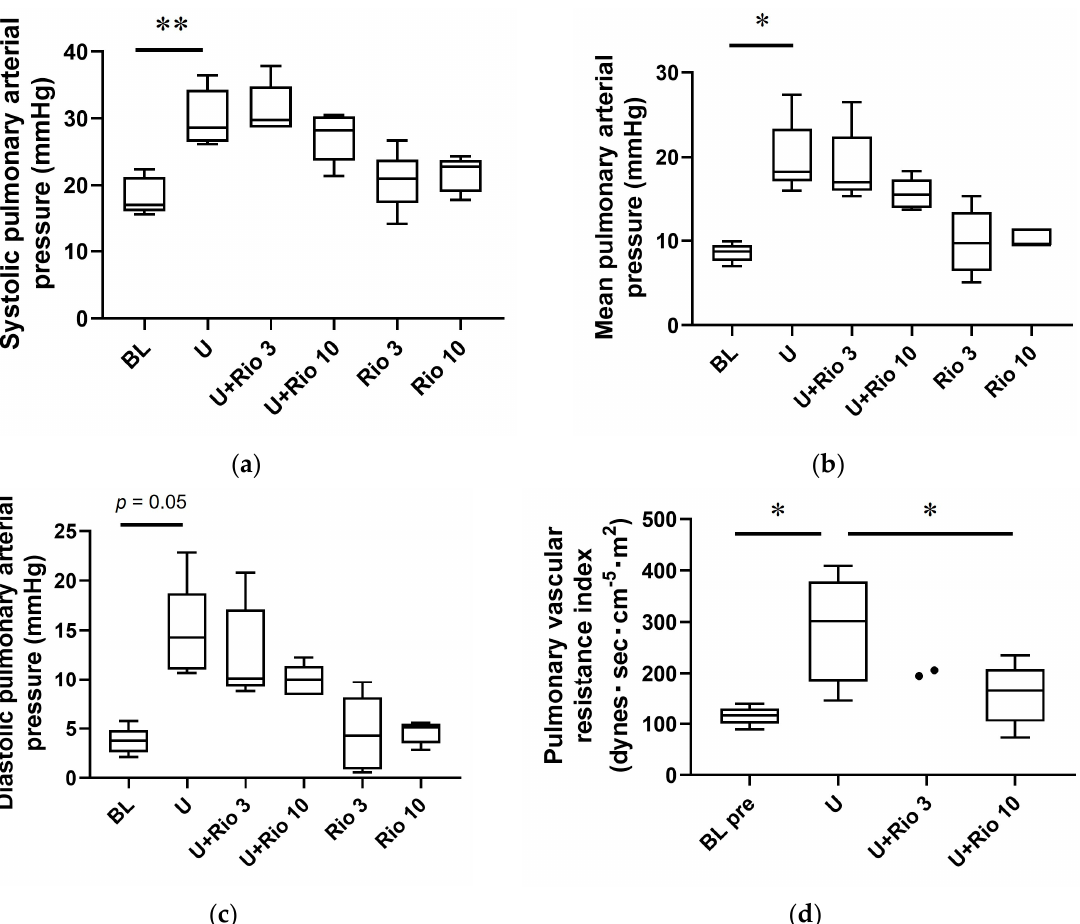
Figure 4. Effect of riociguat on pulmonary arterial pressure of dogs with U46619-induced pulmonary hypertension. A Swan–Ganz thermodilution catheter was inserted through the jugular vein and advanced into the pulmonary artery in anesthetized dogs. Thromboxane A2 analog U46619 (U; 0.9 μ g/kg/min) was infused under simultaneous injection of riociguat (Rio; 3 or 10 μ g/kg/min). Systolic ( a ) and diastolic ( c ) pulmonary arterial pressure (PAP) were measured, and mean PAP ( b ) and pulmonary vascular resistance (PVR) index ( d ) were calculated. In the box plots, the box indicates the interquartile range (25th to 75th percentiles), and the inner line indicates the median (50th percentile); the whiskers are located at the maximum and minimum observation. The PVR index of U46619 + riociguat infusion of 3 μ g/kg per minute (U + Rio3) group (n = 2) was shown as dot plot. * p < 0.05, ** p < 0.01. Table 1. Effects of riociguat on the hemodynamics of dogs with U46619-induced pulmonary hyper- tension. CO: cardiac output; CVP: central venous pressure; d: diastolic; HR: heart rate; m: mean; PAP: pulmonary arterial pressure; PAWP: pulmonary arterial wedge pressure; PVR: pulmonary vascular resistance; Rio 3: riociguat infusion of 3 μ g/kg per minute; Rio 10: riociguat infusion of 10 μ g/kg per minute; SAP: systemic arterial pressure; SVR: systemic vascular resistance; s: systolic; U: U46619 alone; U + Rio 3: U46619 + riociguat infusion of 3 μ g/kg per minute; U + Rio 10: U46619 + riociguat infusion of 10 μ g/kg per minute. The data are shown as mean ± SD. * p < 0.05 vs. baseline, ** p < 0.01 vs. baseline, # p < 0.05 vs. U. Baseline